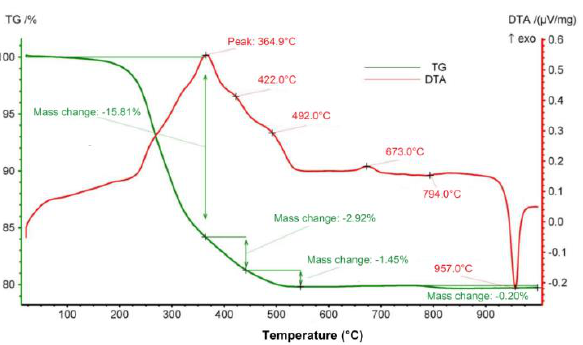
Figure 5. Thermogravimetric measurements (TG)–differential thermal analysis (DTA) of 50% Zn 4 B 6 O 13 –50% Zn 2 SiO 4 green tape.